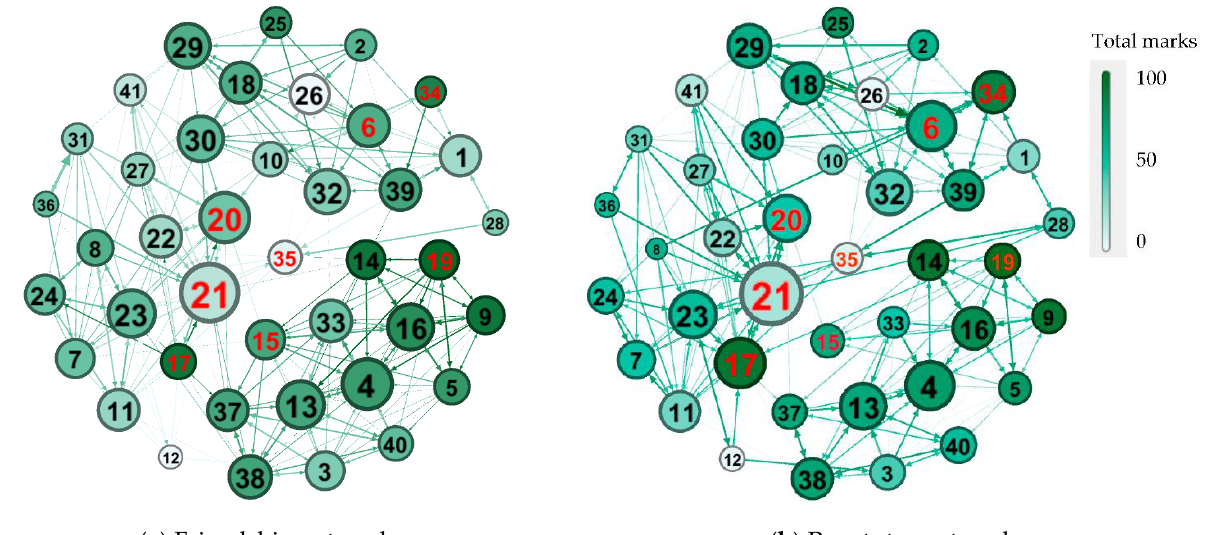
Figure 4. The size of the node represents weighted indegree and its color represents the total marks. Larger nodes represent higher weighted indegree and darker colored nodes represent higher marks. Red font is used to highlight the nodes that will be discussed in this section.